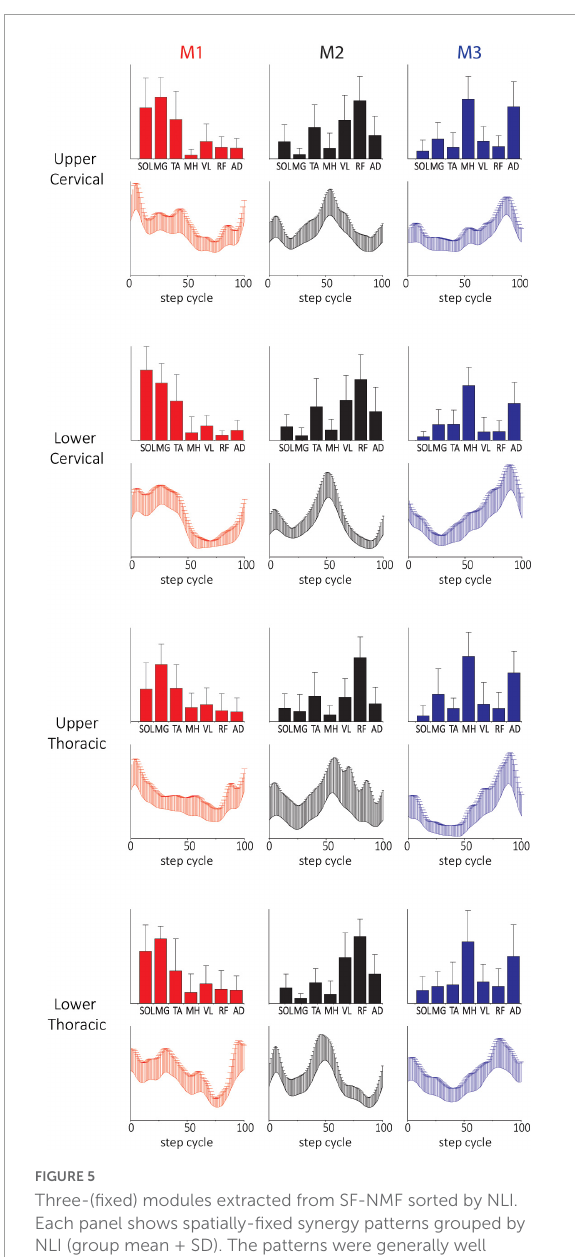
FIGURE5 Three-(fixed) modules extracted from SF-NMF sorted by NLI. Each panel shows spatially-fixed synergy patterns grouped by NLI (group mean + SD). The patterns were generally well correlated across NLI categories. See Supplementary Table 3 for details on